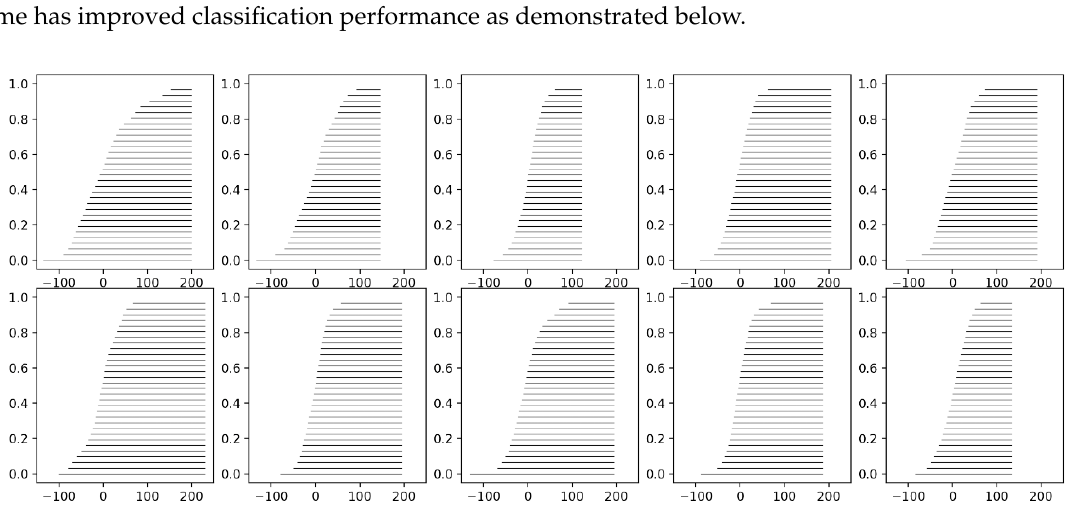
Figure 3. IN interval representations in N = 10 windows of the EEG signal shown in Figure 1a.